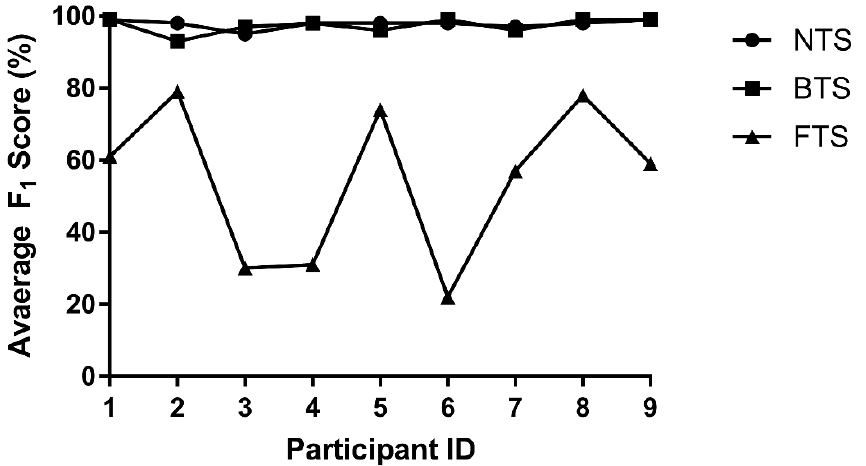
Figure 11. Heel contact timing detection error.